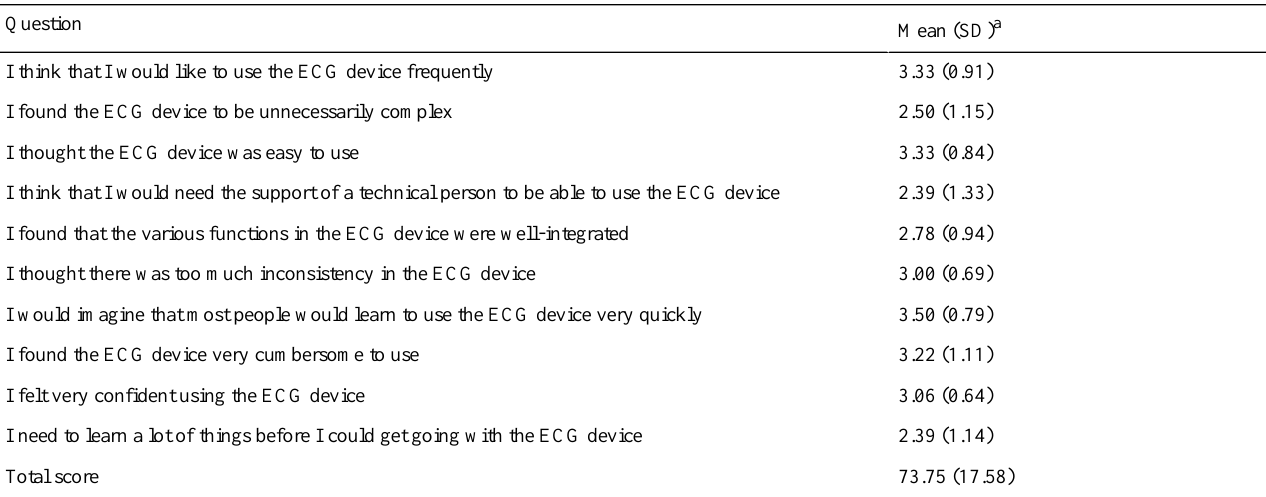
Table 4. System Usability Scale adapted for assessment of participant satisfaction with the patchy-type wireless electrocardiogram (ECG)